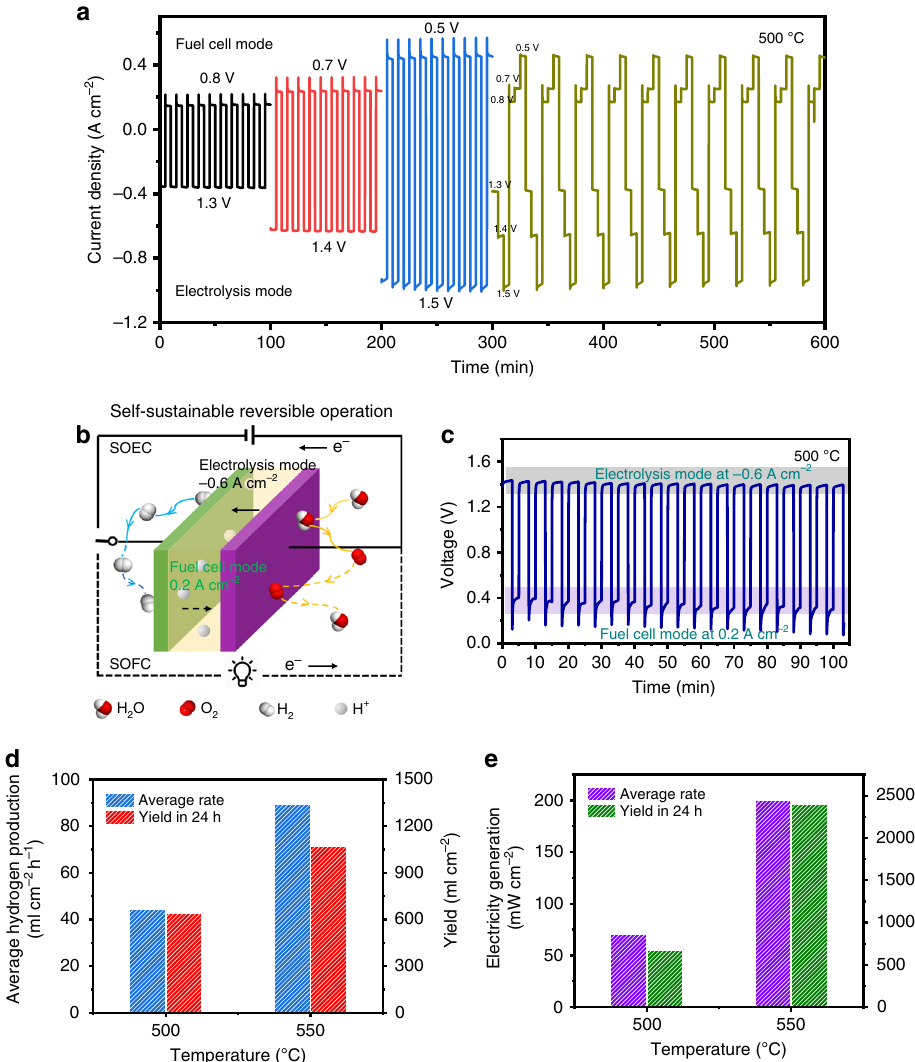
Fig. 6 Reversible operation and analysis in hydrogen and power generation. The cycling reversible operation of the electrochemical cell between electrolysis mode (hydrogen production) and fuel cell mode (electricity generation) at different current densities to examine the capability of converting hydrogen generated by electrolysis into electricity. a Reversible operation with external hydrogen supply: current density responses as working mode transiently changing between electrolysis and fuel cell at 500 °C. b Schematic of self-sustainable reversible operation without external hydrogen feeding. c Voltage observation under switchable electrolysis and fuel cell current densities at 500 °C. d Average hydrogen production based on results on current density and Faradaic ef fi ciency and hydrogen yield assuming the cell is operated for 24 h. e Average electricity generation rate and electricity yield in 24